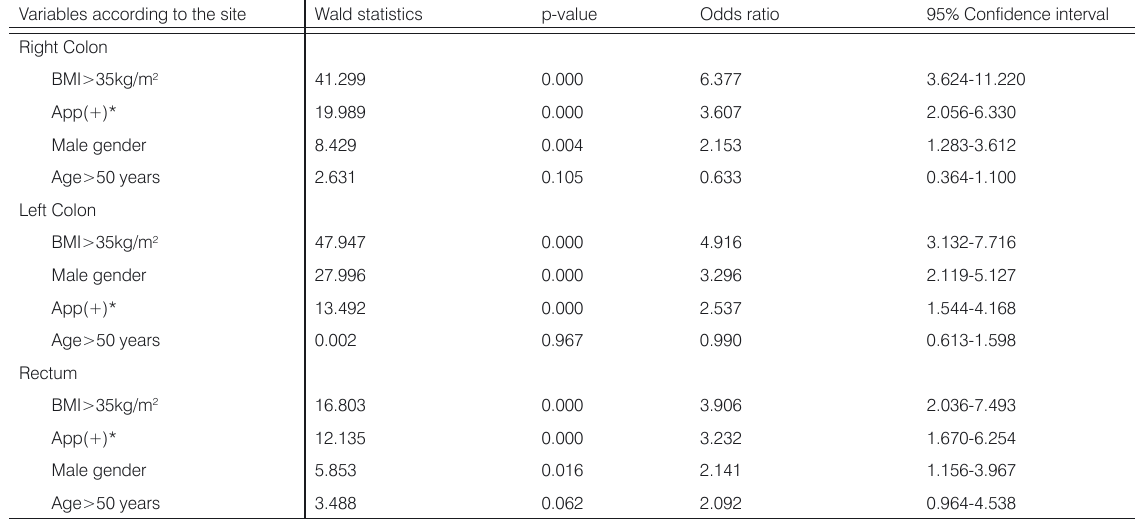
Table 1. Statistical analysis of the variables according to the